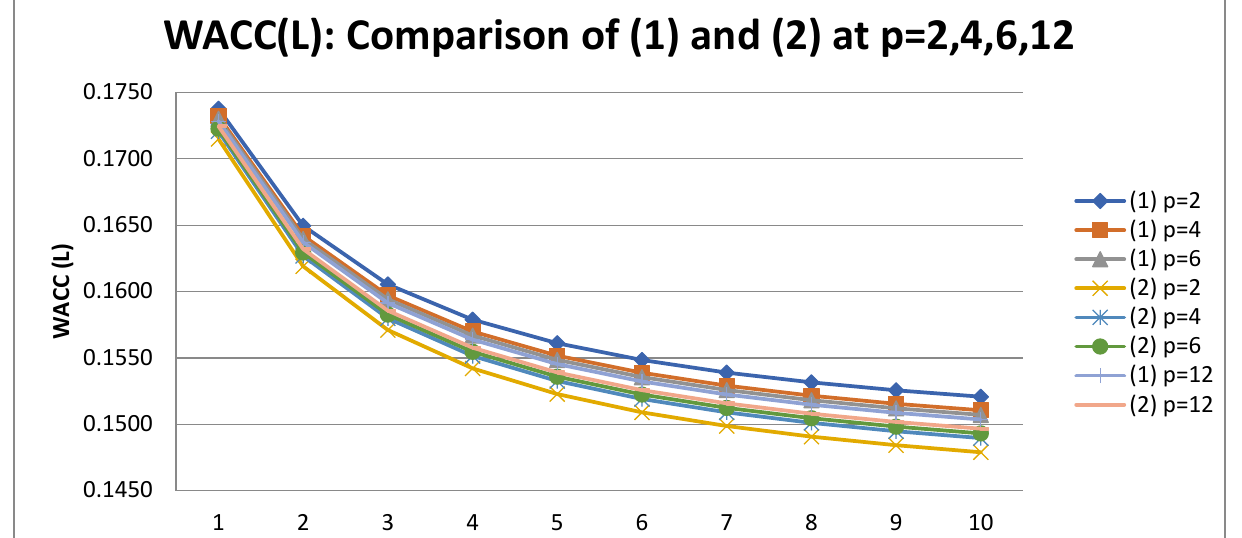
Figure 4. The comparison of the dependence of the WACC on the leverage level ( L ) of a three-year-old company for profit tax payments that were (1) made at the end of the financial period and (2) made at the beginning of the financial period (i.e., advance payments) with frequencies of p = 2, 4, 6 and 12. The WACC ( L ) decreased with L in both cases: advance profit tax payments and payments at the end of the financial year. This meant that debt financing was important and should be used by the company as it led to a decrease in the corresponding capital cost with L